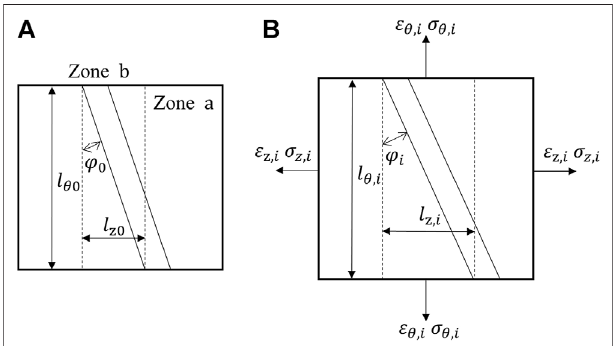
FIGURE 5 | Top views of the M-K model in (A) undeformed stage and (B) deformed